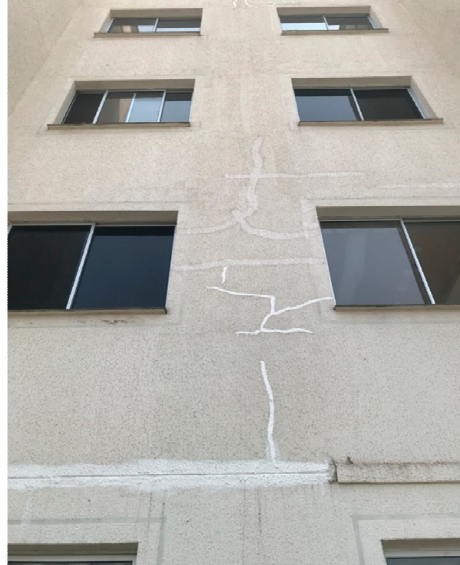
Figure 3. Crack sealing with leveling putty.